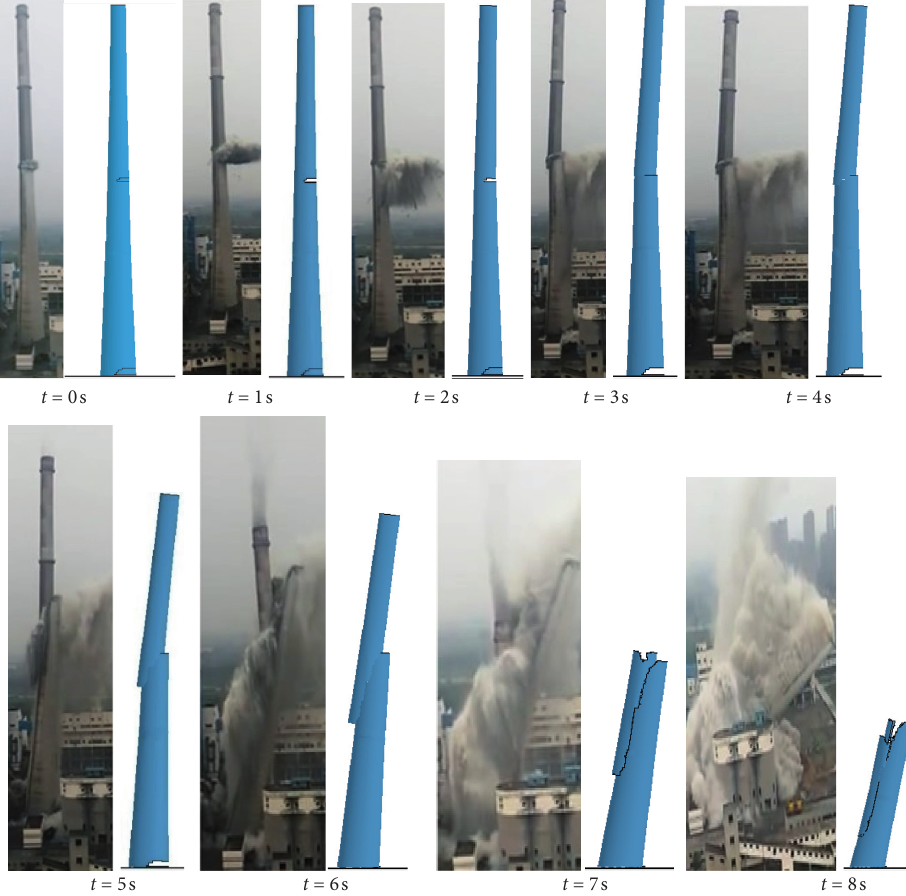
Figure 13: Comparison between numerical simulation and actual collapse process of chimney blasting